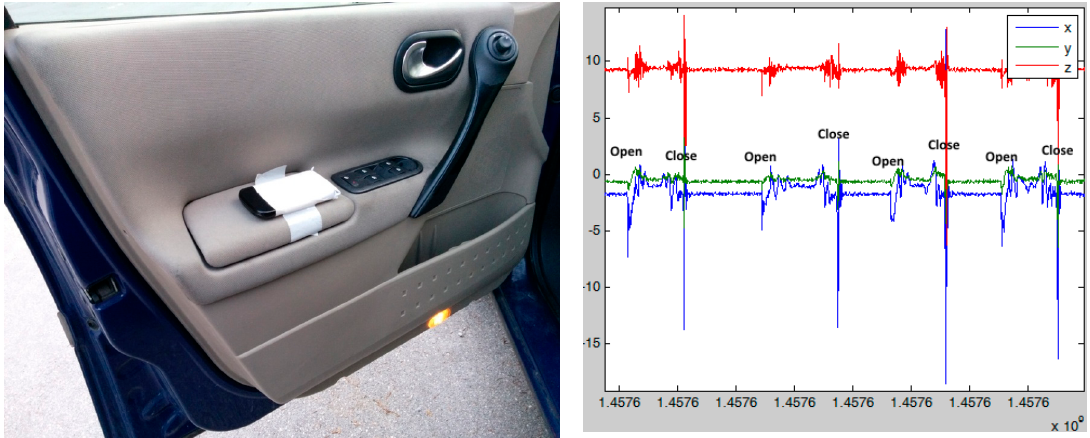
Figure 4. An Android smartphone for collecting of car door data ( left ) and example of these data ( right ).